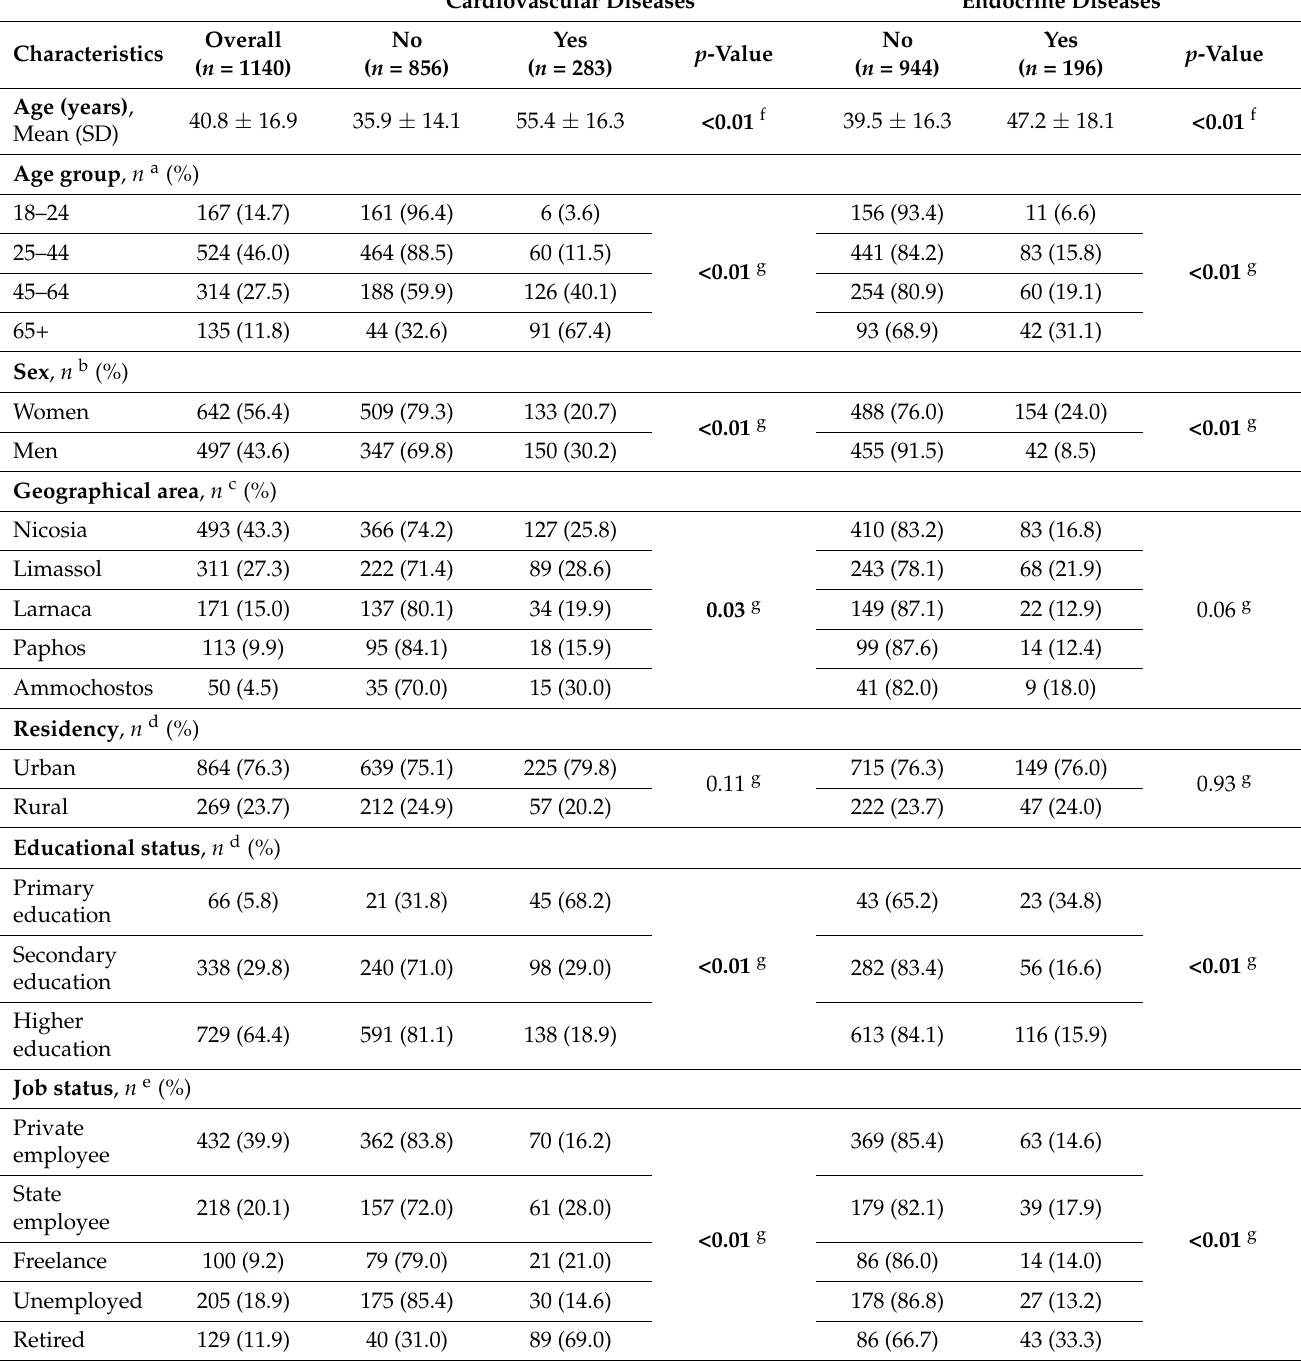
Table 1. Demographics and socioeconomic characteristics overall, and by participants’ health status (cardiovascular diseases and endocrine diseases groups). Cardiovascular